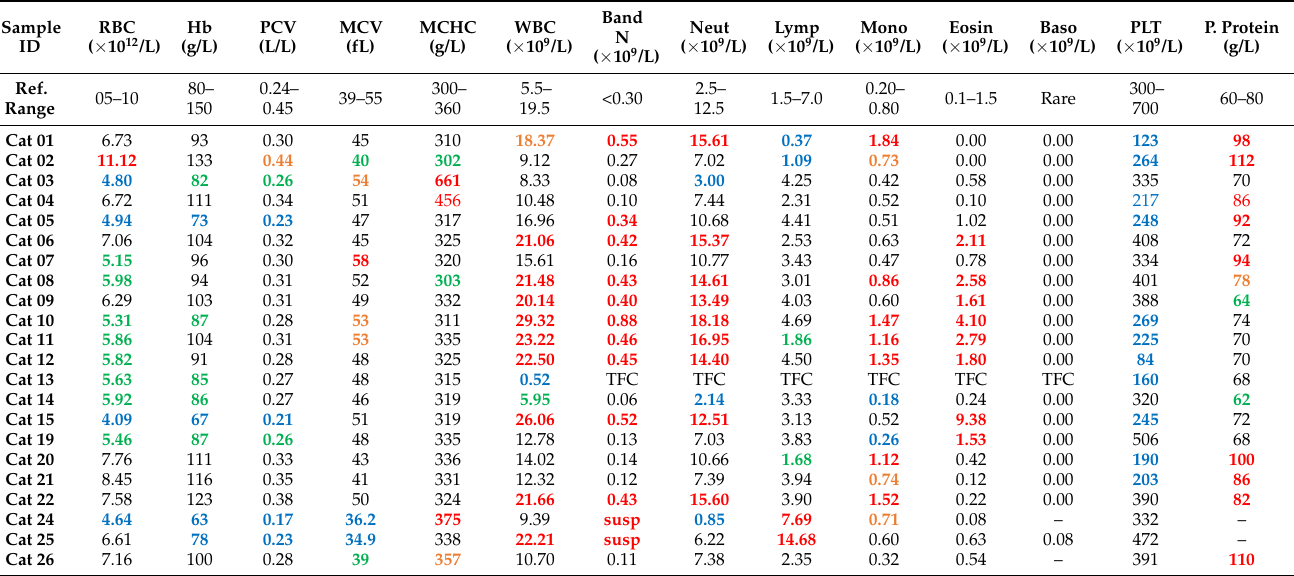
Table 4. Hematological findings for a total of 22 (19 shelter and 3 privately owned) cats manifested acute/chronic infectious respiratory disease signs.